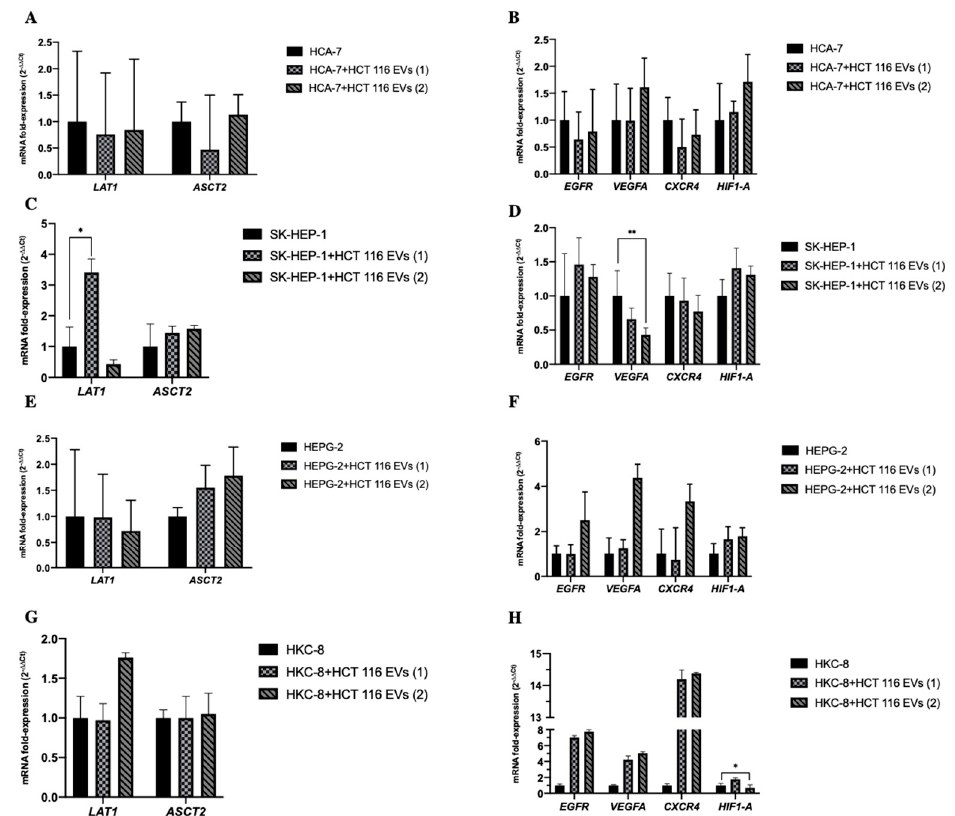
Figure 5. The bars represent the fold change of the mRNAs expression, normalized to B2M . Variation of levels of LAT1 , ASCT2 , EGFR , VEGFA , CXCR4 and HIF1-A mRNAs in recipient cells after HCT 116-EVs’ uptake. Three biological replicates of each cell line were used for this experiment. ( A , C , E , G ) The graphs demonstrate that the HCT 116-EVs condition 1’s uptake leads to an increase of LAT1 mRNA expression level by SK-HEP-1 cells. ( B , D , F , H ) Additionally, the HCT 116-EVs condition 2’s uptake decreases the expression level of VEGFA mRNA in SK-HEP-1 recipient cells. In HKC-8 recipient cells, the HCT 116-EVs condition 2 uptake induces a decrease of HIF-1A mRNA expression level . (Mean ± Std. Error, ** p < 0.001, * p < 0.05).